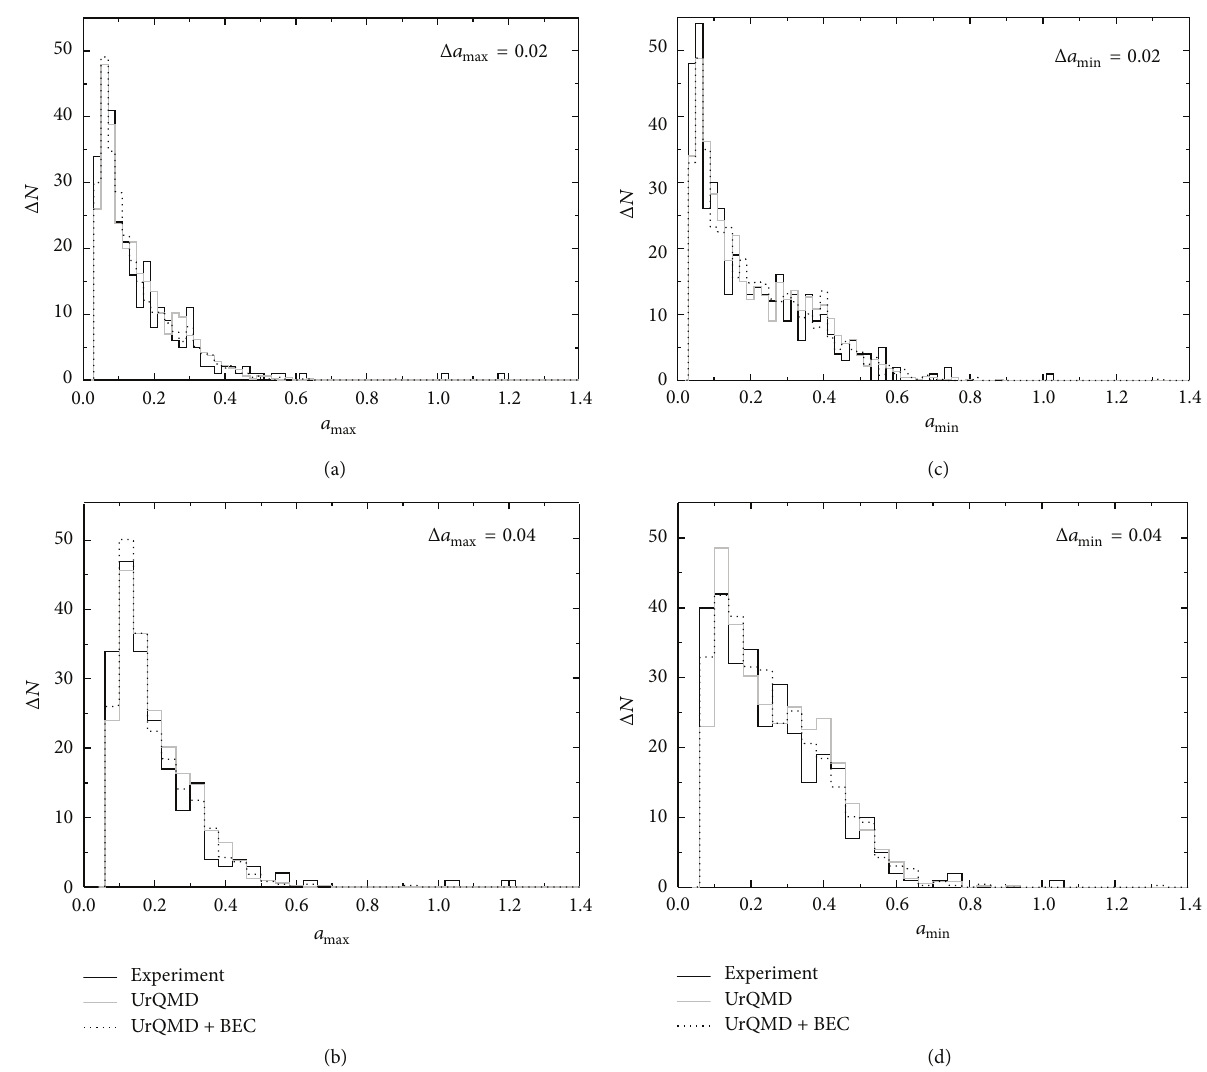
Figure 7: Same as Figure 6 but for 32 S-Ag/Br interaction at